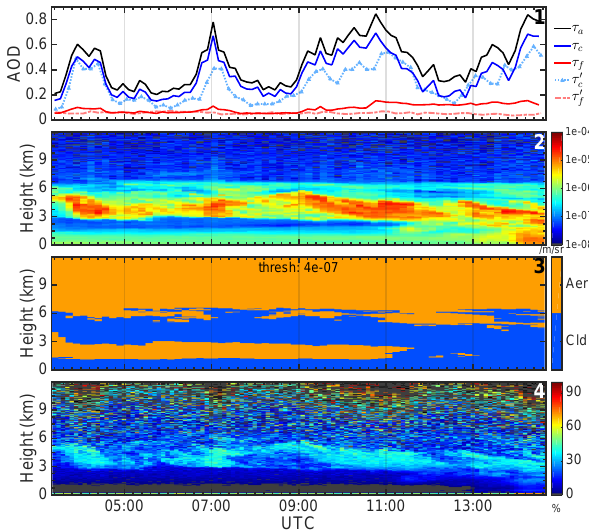
Figure 8. Thin cloud event of 21 February 2011. The description of the top 3 panes is identical to the description given in Fig. 4. Pane 4 is the CRL linear depolarization ratio (%). The depolarization ratio data were not corrected for overlap in the bottom-most